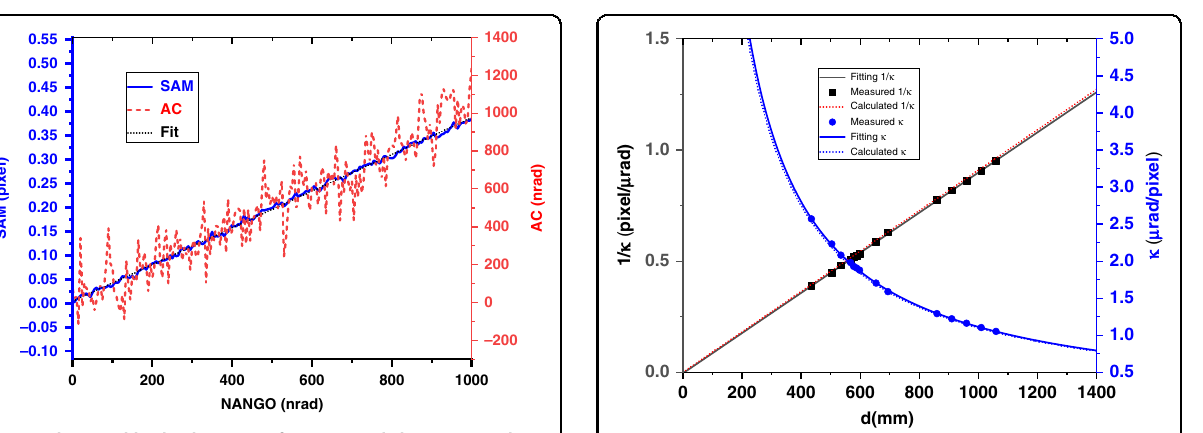
fully calibrate the SAM system, NANGO is fi xed on a motorized platform, and the distance d between the SAM and NANGO can be precisely changed with a linear motor. The above fi tting procedure (in Fig. 9) is repeated at a few distances d . As expected, the fi tting slope 1/ κ (black dot curve) is linearly proportional to the distance d in Fig. 10. By linearly fi tting the 1/ κ with the distance d , we extract the measured distance error Δ d = 4.2 mm from the fi tting intercept. This error is due to the devia- tion from the exact camera sensor position. The system calibration coef fi cient κ is plotted as a function of the measured distance d , and the calibration coef fi cient κ is used for SAM metrology. For instance, the distance d between the test mirror surface and SAM camera is 514 mm, and the measured calibration coef fi cient κ = 2.140. If the measured distance is 513 mm, the corre- sponding calibration coef fi cient κ = 2.144. In other words, the calibration coef fi cient error is then 0.2% if the measured distance error is within 1 mm at this working distance.